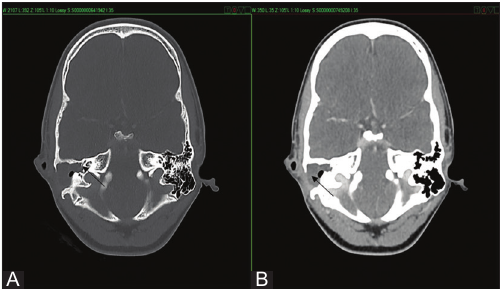
FIGURE. 2. (A) Axial view of high-resolution computed tomography temporal post right modified radical mastoidectomy showed the absence of ossicles (arrow). (B) Soft-tissue view showed the presence of soft-tissue density in the mastoid cavity